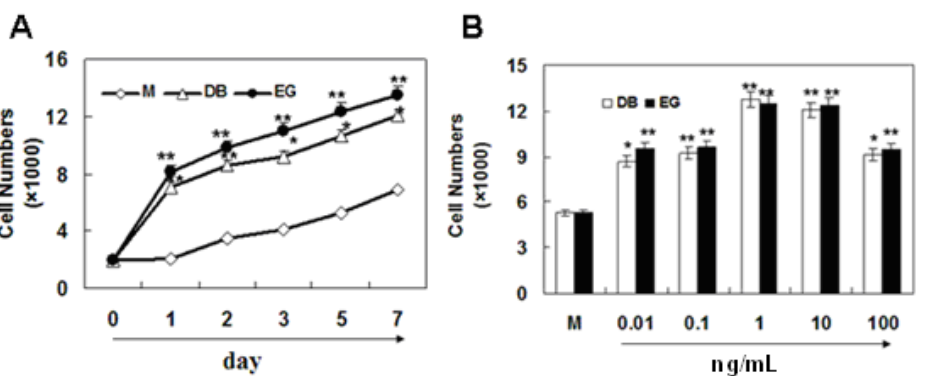
Figure 2. EG increases the proliferation of MC3T3-E1